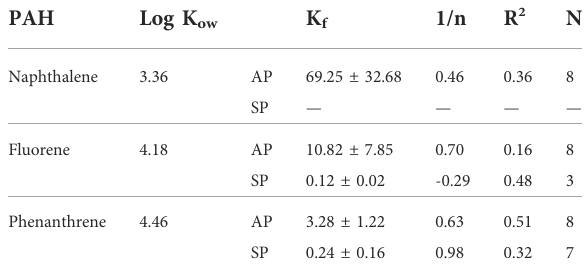
TABLE 5 Estimated parameters of the Freundlich model for WAF PAH sorption to 4.5 μ m MPs, according to data obtained from